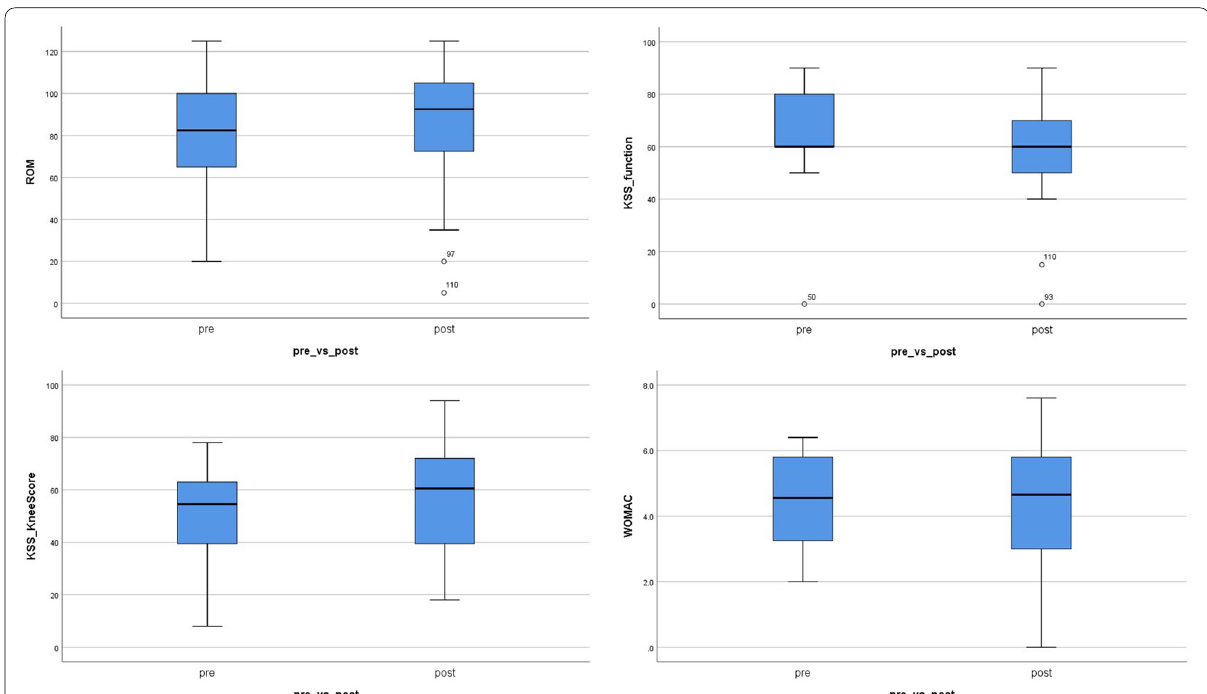
Fig. 3 Comparison of the range of motion (ROM), Knee Society Score (KSS), and Western Ontario and McMaster Universities Osteoarthritis Index (WOMAC) before and after proximalisation of the tibial tubercle